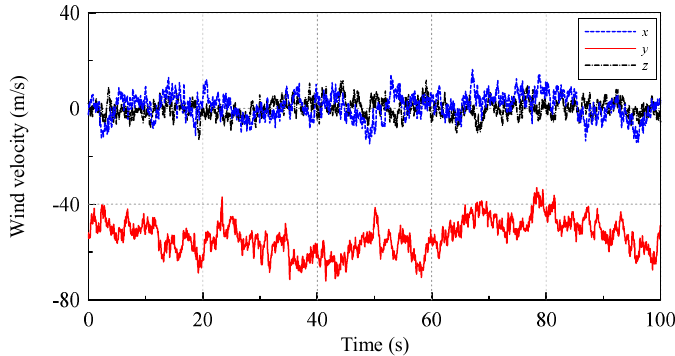
Figure 14. 50-year, 10 min average extreme wind speed V ref = 54.16 (m / s) at 90 m elevation.